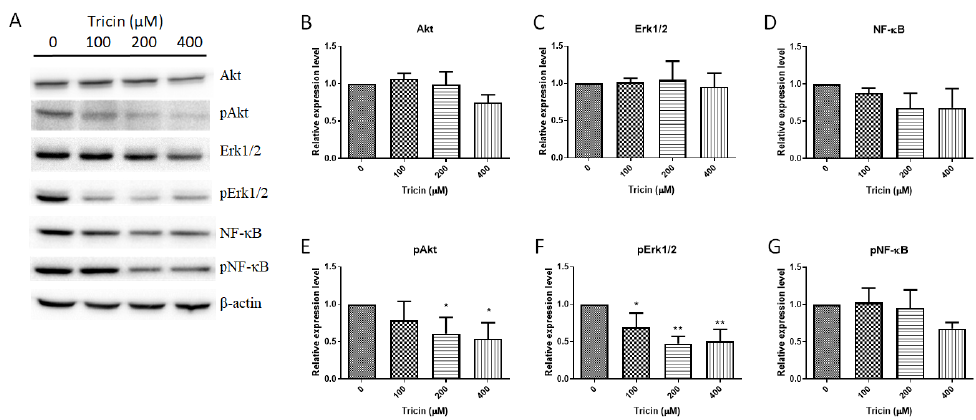
Figure 2. Effects of tricin on protein expressions in HT29 cells. Proteins were extracted from cells incubated with tricin for 24 h and subjected to western blot analysis. ( A ) Representative blots (four protein samples from each group) show the effects of tricin on the expressions of ( B – D ) total Akt, Erk1/2, NF-κB and ( E – G ) their phosphorylated forms. Original blots are provided in the Supplementary Information. Histograms show the quantitative target proteins expression results normalized with the corresponding β-actin expressions and expressed as relative expression levels. Data were expressed as the mean + S.D. (n = 4). Differences among treatment groups were determined by one-way ANOVA followed by Tukey’s multiple comparisons test, * p < 0.05, ** p < 0.01 as compared with control group.